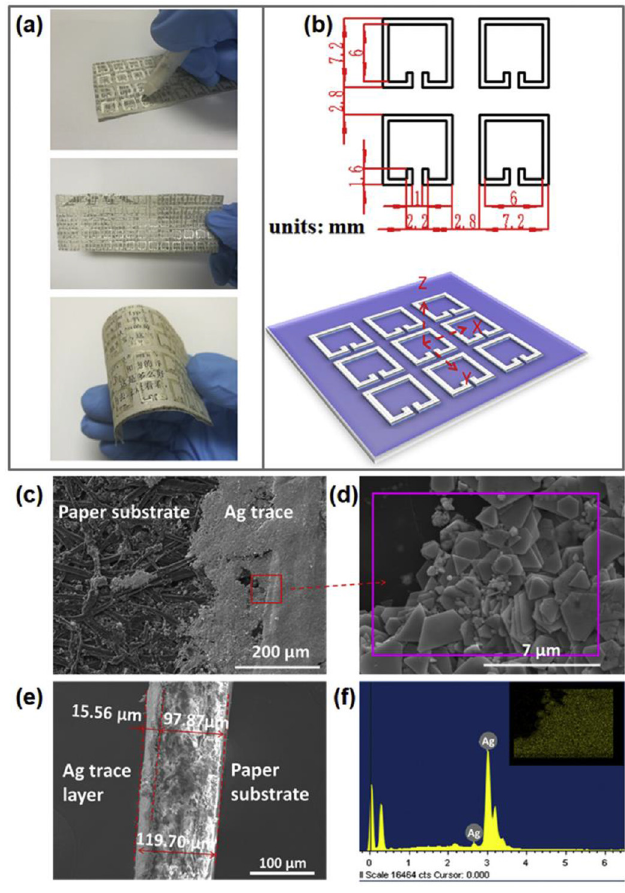
Fig. 5. SRRs designs formed on paper based substrates. (a) SRRs being drawn on paper using rollerball pen with conductive silver ink, (b) Schematic diagram of the electromagnetic simulation model and the dimensions of SRRs, (c and d) SEM images of silver trace on the substrate, (e) SEM image of silver pen trace on a single paper fi ber, (f) energy dispersive spectroscopy (EDS) mapping of area marked by square in (d) [71]. Reproduced with permission from Z.